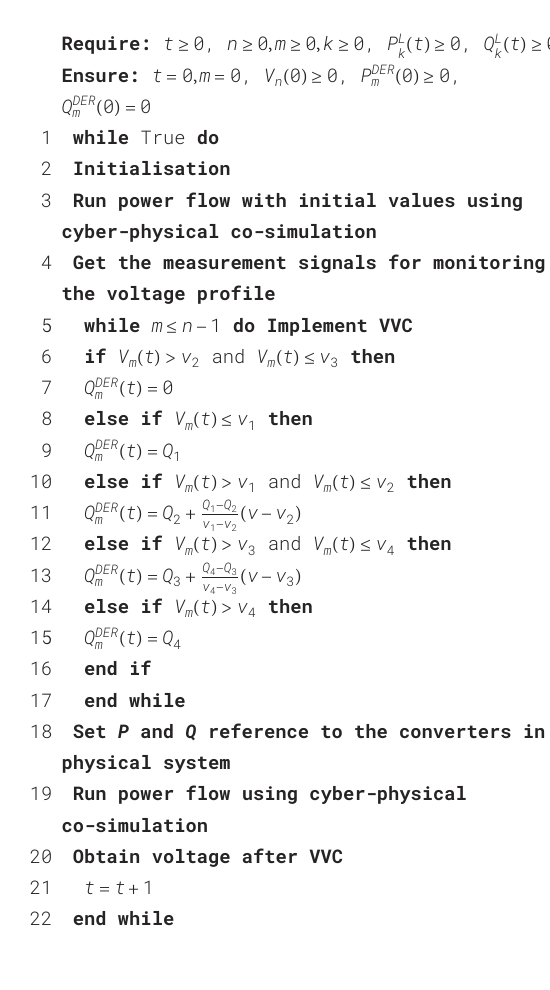
Algorithm1. Analgorithmforreal-timeVolt-Var